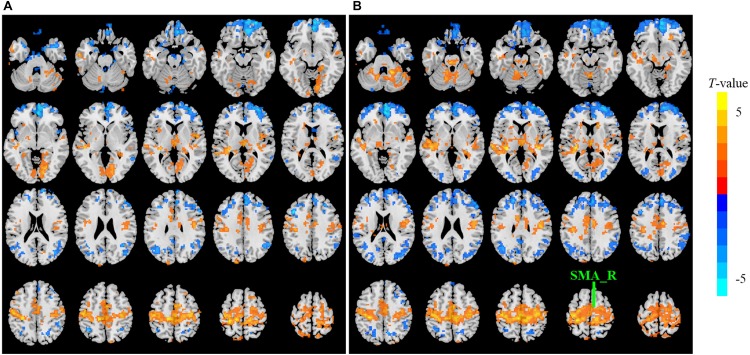
The t map (p < 0.05, cluster size ≥ 10 voxels) of eyes closed (EC) versus eyes open (EO) in Slow-2 (0.1992–0.25 Hz) by FFT-ALFF (A) and db2-ALFF (B), respectively. Warm colors indicate higher ALFF in EC conditions. ALFF, amplitude of low-frequency fluctuation; FFT, fast Fourier transform; SMA_R, right supplementary motor area.